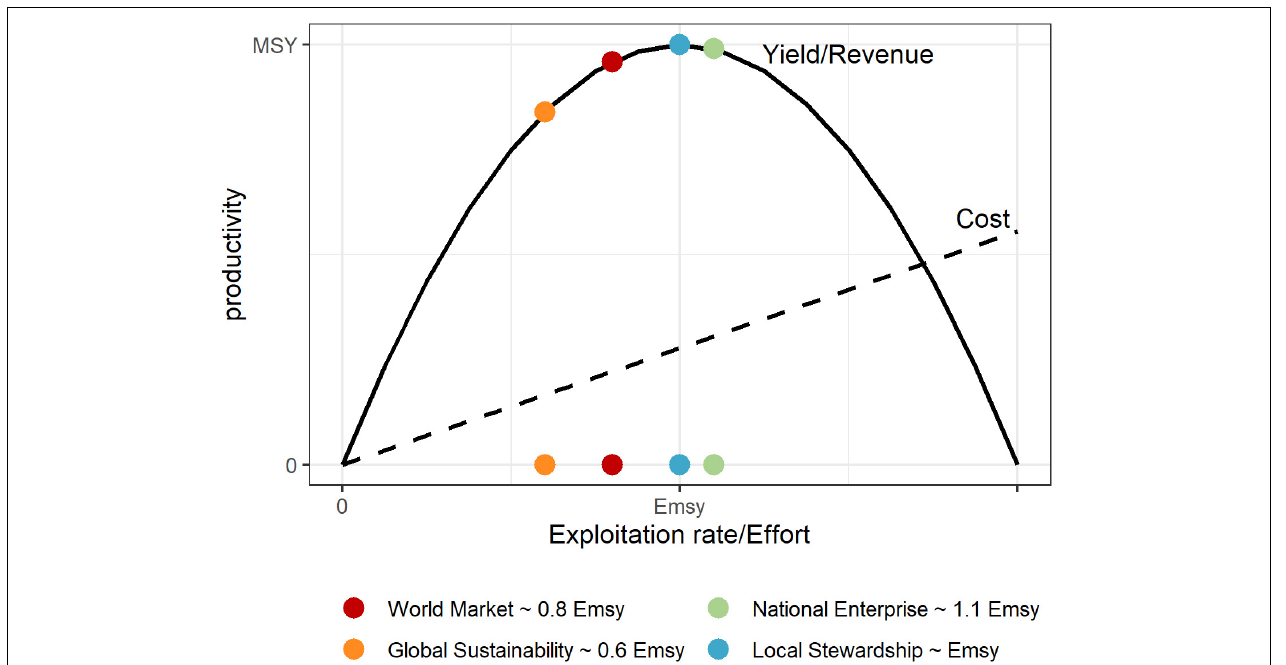
FIGURE 2 | Exploitation levels for the four CERES scenarios relative to the exploitation rate/effort associated with the Maximum sustainable yield (E msy